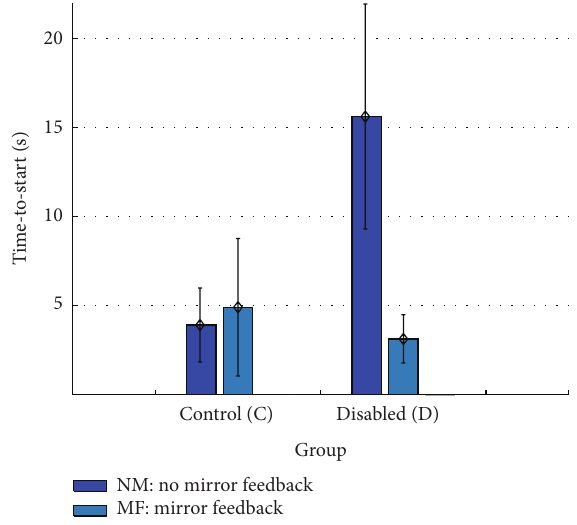
Figure 6: Overview of mean times for the time-to-start measure ( 𝑇 𝑠 ).